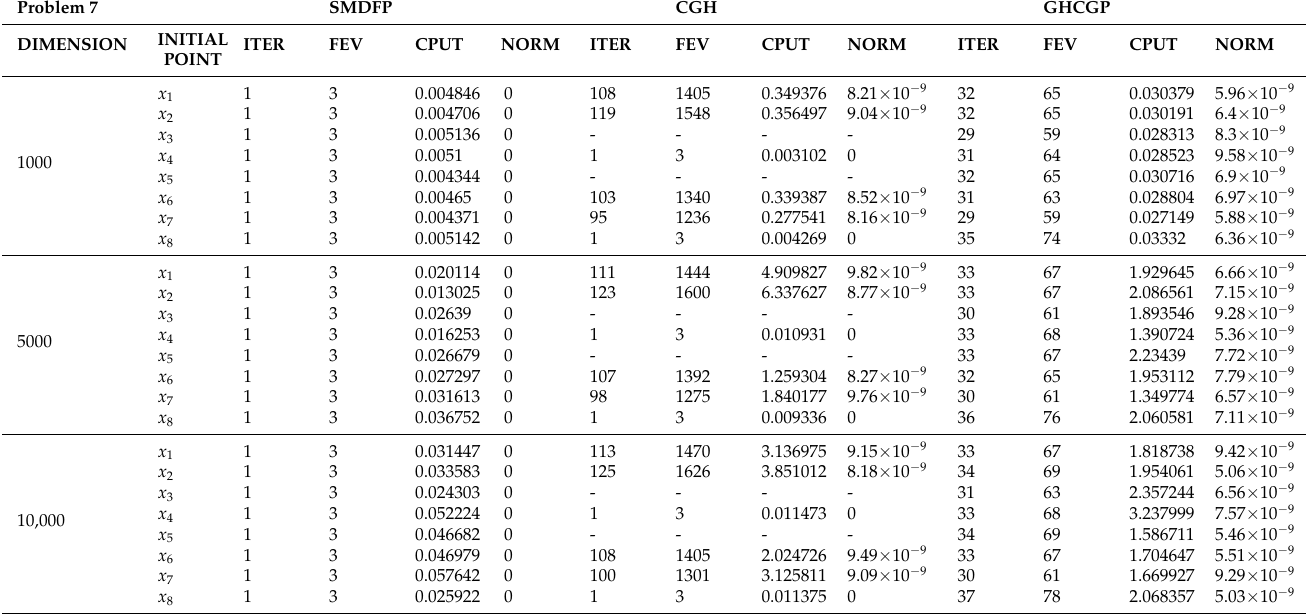
Table 7. Numerical comparison of the SMDFP, CGH [61], and GHCGP [62]